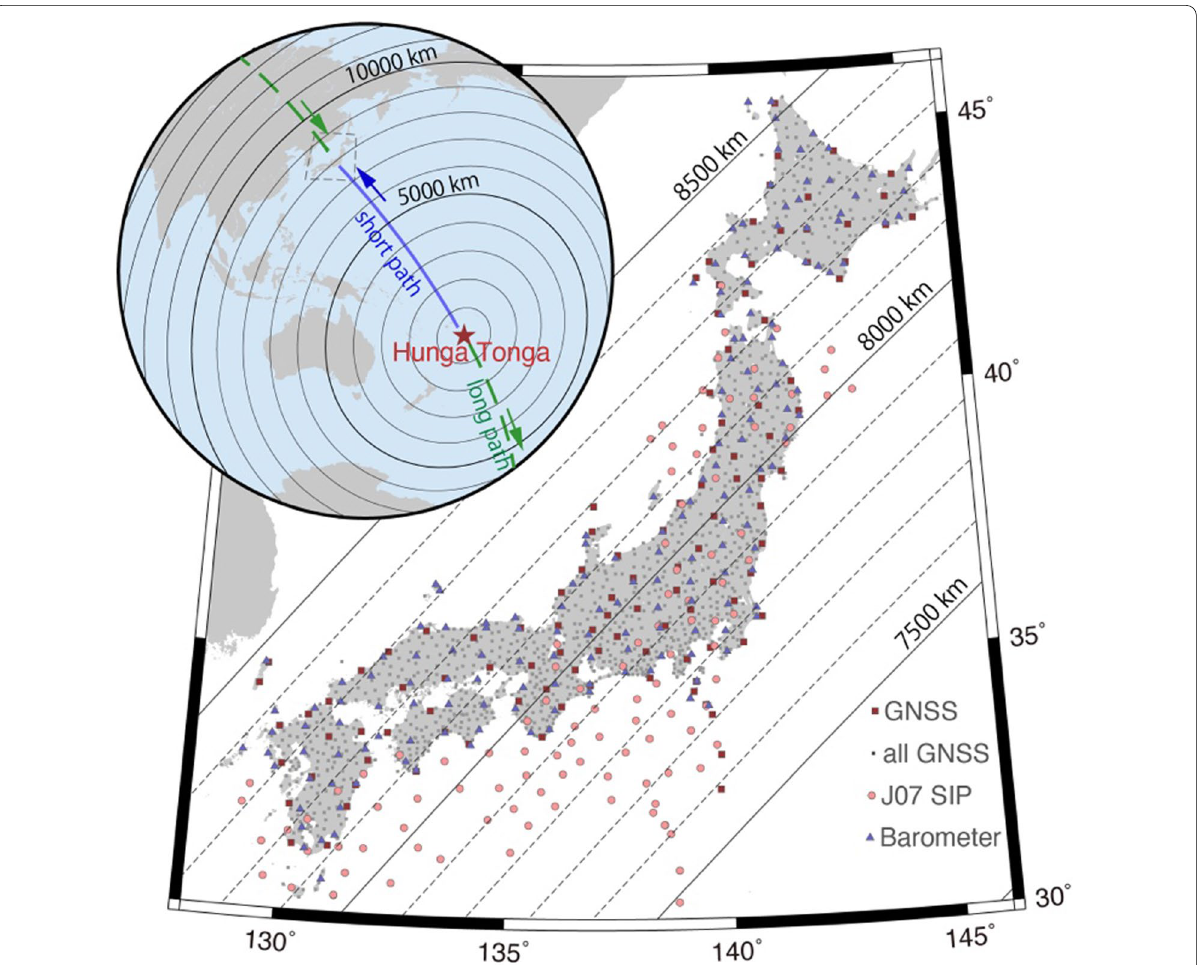
Fig. 1 Distribution of all (gray dots) and selected (dark red squares) GEONET GNSS stations, and selected Soratena weather sensor stations (triangles). Red circles indicate sub-ionospheric points (SIPs) for J07 (QZSS geostationary satellite). When we observe QZSS quasi-zenith orbit satellites (J01, 02, 03), SIPs stay close to the GNSS stations. Distances from the Hunga Tonga-Hunga Ha’apai volcano are indicated with black lines. The location of the volcano (red star), short and long paths from the volcano to Japan (blue and green curves) are given in the inset